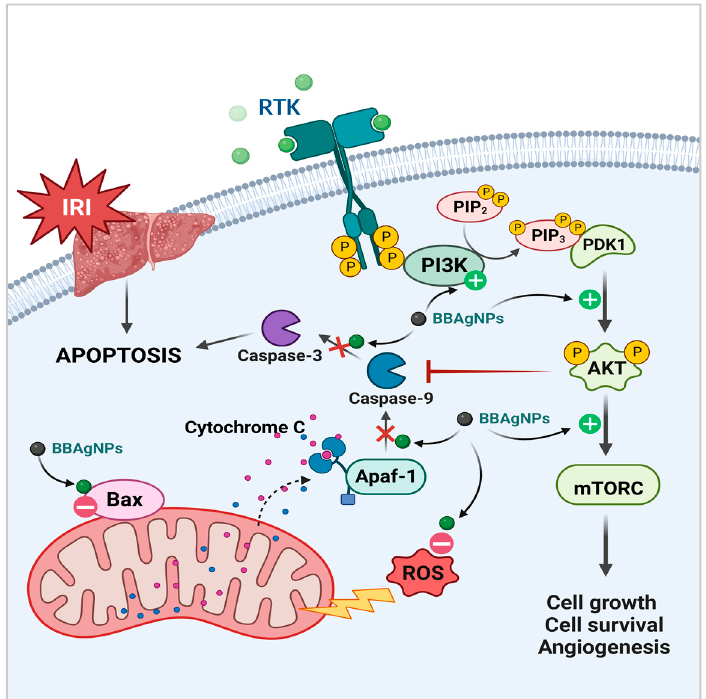
Figure 12. A hypothetical scheme of BBE -loaded AgNPs protection to hepatic ischemia/reperfusion injury (IRI). When the liver is subjected to ischemia/reperfusion, the expression of Bax is strongly induced, which leads to release of cytochrome c from mitochondria and formation of Apaf-1 which activate Caspase-9 and then Caspase-3 in hepatocytes leading to apoptosis. On the other hand, the inhibited PI3K/Akt/mTOR pathway inhibits cell growth and cell survival. Therefore, the PI3K/Akt/mTOR pathway activation by BBE -AgNPs components may regulate the expression of genes closely associated with apoptosis such as Bax, Caspase-9 and Caspase-3 leading to attenuation of liver injury after IR (created with BioRender.com).